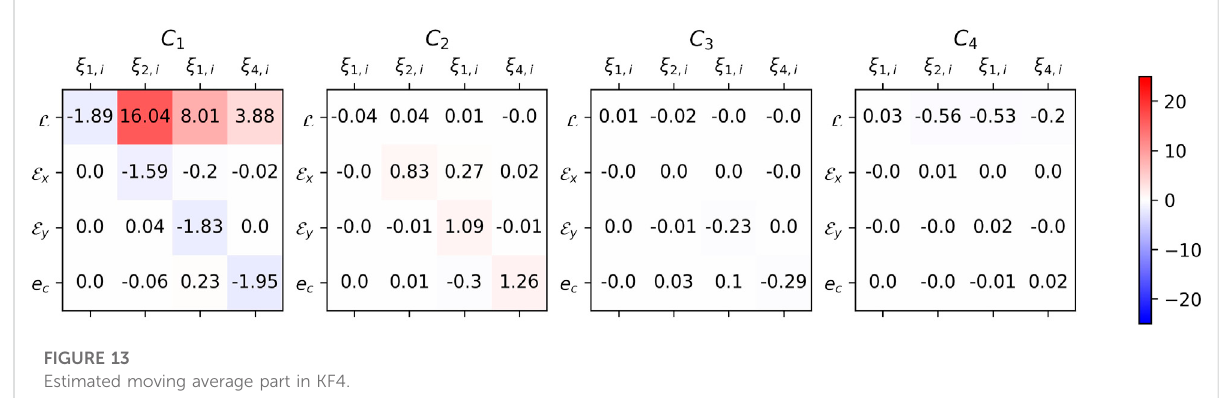
2018, so that 1) for each horizon, the prediction of at least 10 different fi lls should contribute to computation of R 2 and 2) a number of aggregated prediction was not less than 10 3 . Training on 2017: Figure 8 shows how the R 2 varies for different horizons H for the models trained on the data from